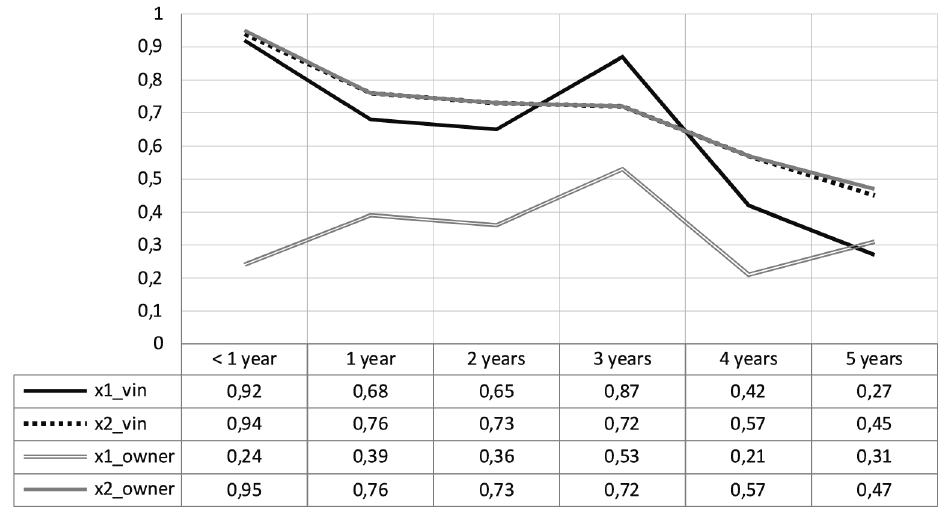
and SOSE retention rates in 2018 for the VIN CUS